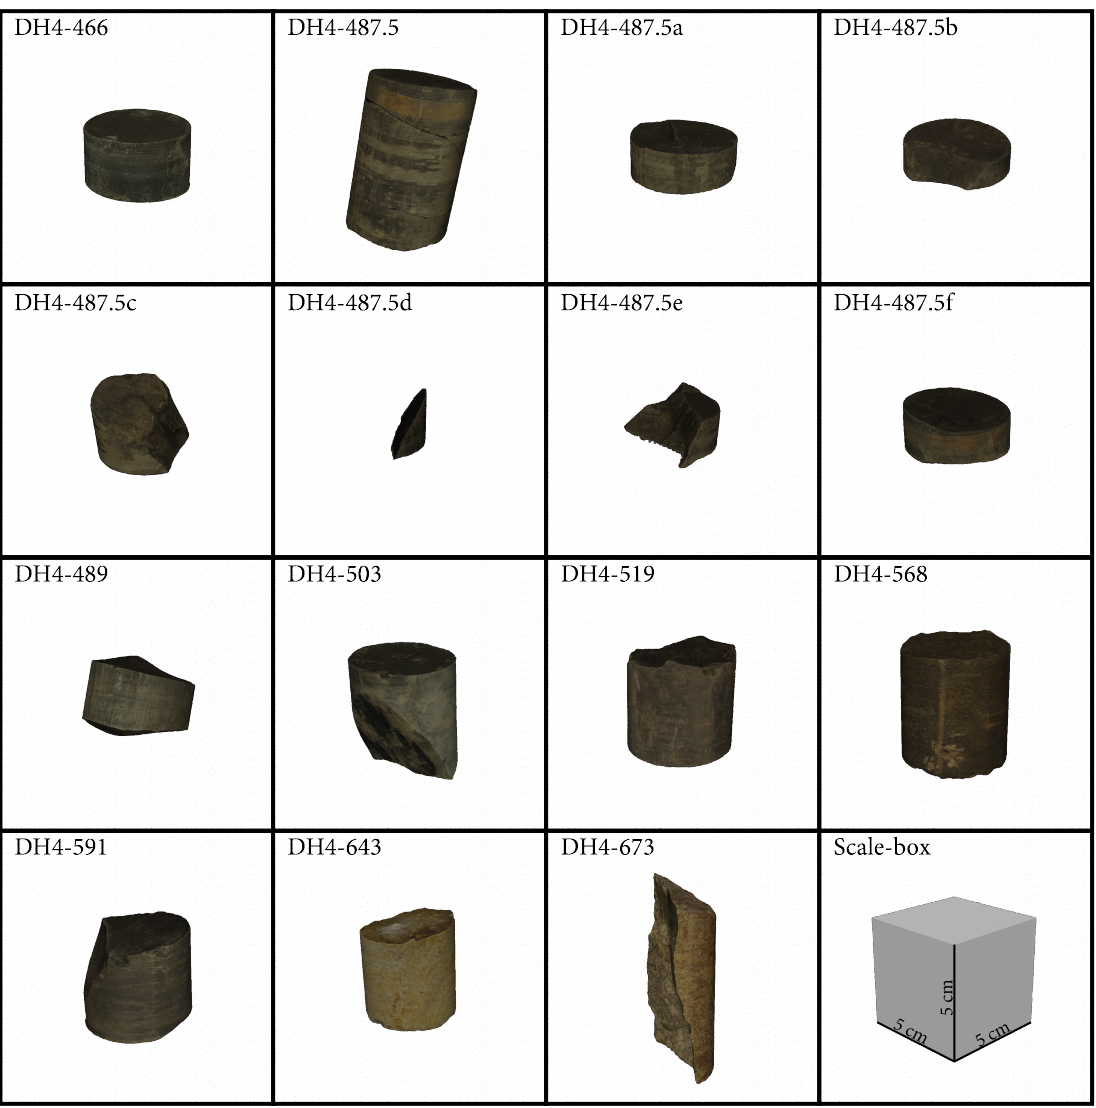
Figure 3. An overview of the digitised DCMs (excluding sub-fragments and DH4-591w), universally scaled. Dimensions and origins are available in Table